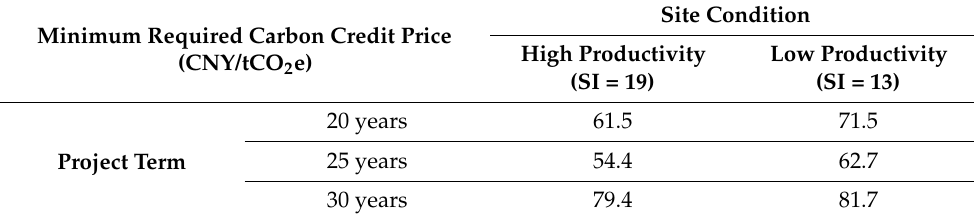
Table 3. Minimum carbon credit prices required to enroll in a larch carbon sink project under varying project terms and site conditions in Gansu, Northwest